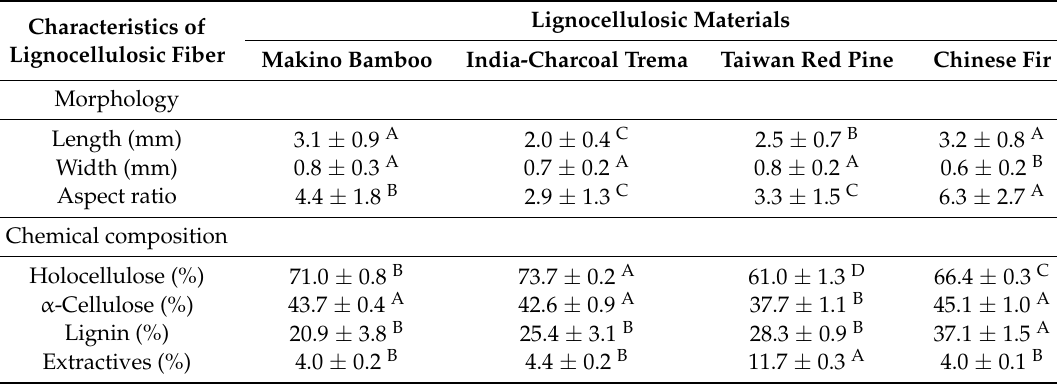
Table 1. Morphology and chemical composition of different lignocellulosic fibers.